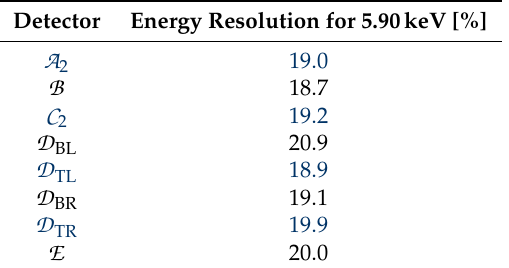
Table 2. Average energy resolution for selected